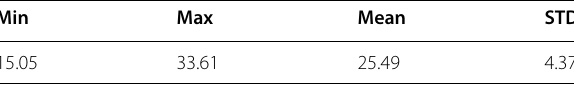
Table 1 Geoidal heights of KNGeoid18 (unit: